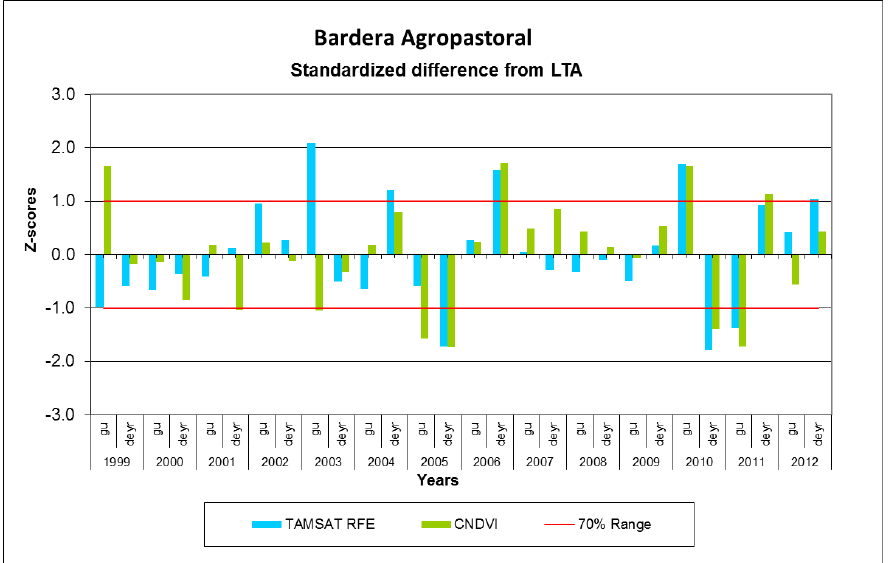
Figure 3. Z-scores (standardized differences from long term average (LTA)) of cumulated NDVI and rainfall estimates over the two crop seasons (called Gu and Deyr) of an agro-pastoral district in Southern Somalia (Bardera). The two failed seasons in 2010 and 2011, which lead to a major famine in the country are clearly visible. In most cases a major NDVI anomaly is explained by a similar rainfall anomaly, but this is not always the case, as for example in the Gu season of 2003. In such cases temporal distribution of rainfall has to be taken into consideration as well as non-rainfall related factors influencing the NDVI , such as changes in crop